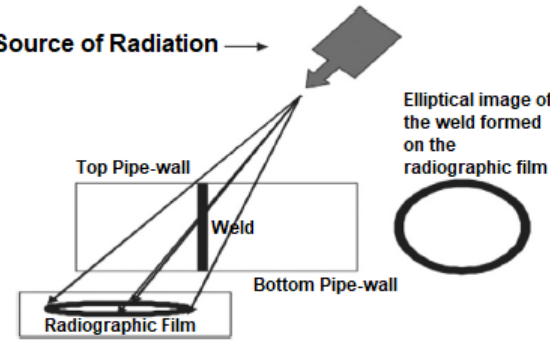
Figure 46. The operating principle of the DWDI technique. Reprinted from NDT & E International, Volume 86, Boaretto, N.; Centeno, T.M. Automated Detection of Welding Defects in Pipelines from Radiographic Images DWDI, Page 7–13, Year 2017 with permission from Elsevier [129].